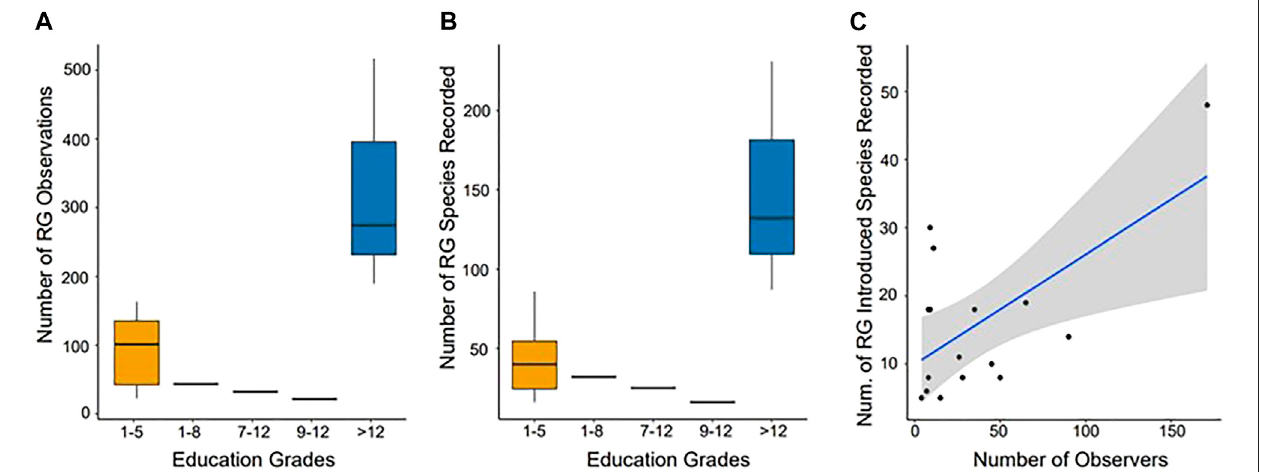
FIGURE 4 | Observer characteristics in fl uencing the amount of research grade data collected. The number of (A) observations and (B) species recorded as research grade were in fl uenced by education level. The large contributions of college-level students ( > 12 education grades) were the primary driver of this relationship. (C) The number of introduced species recorded as research grade increased with the number of